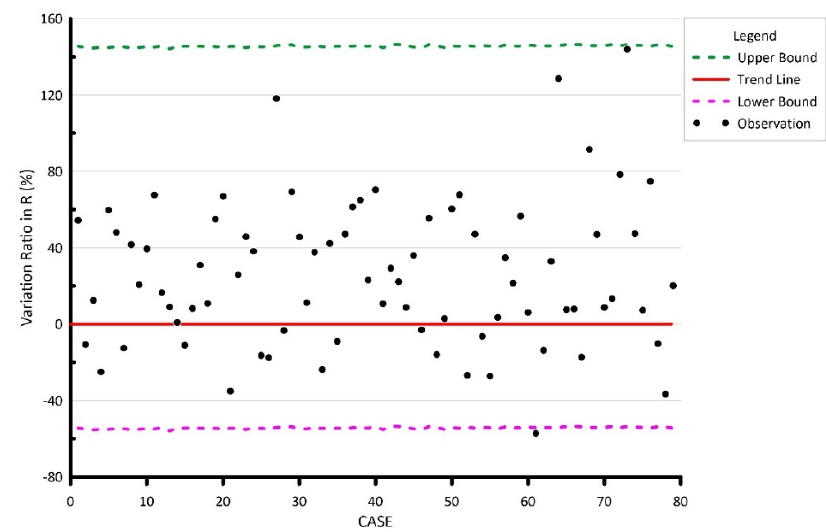
Figure 11. Prediction of rainfall distribution by linear analysis of 149 potential LSL areas.